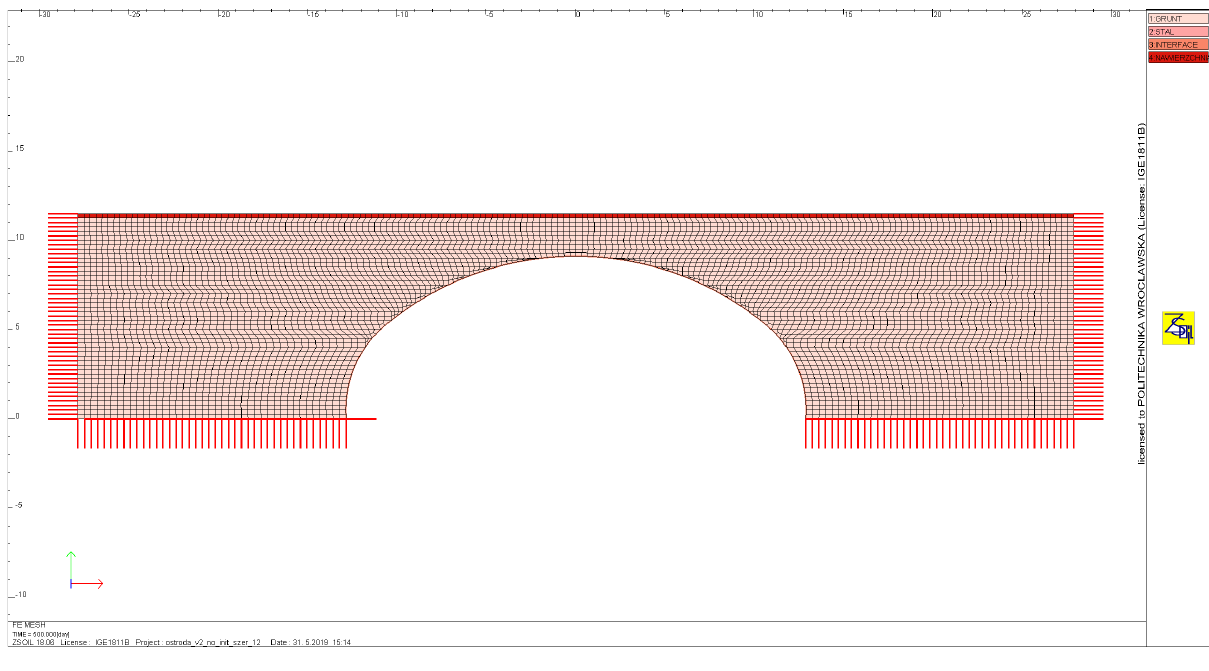
Figure 8: Geometry and finite element mesh adopted in the numerical model.